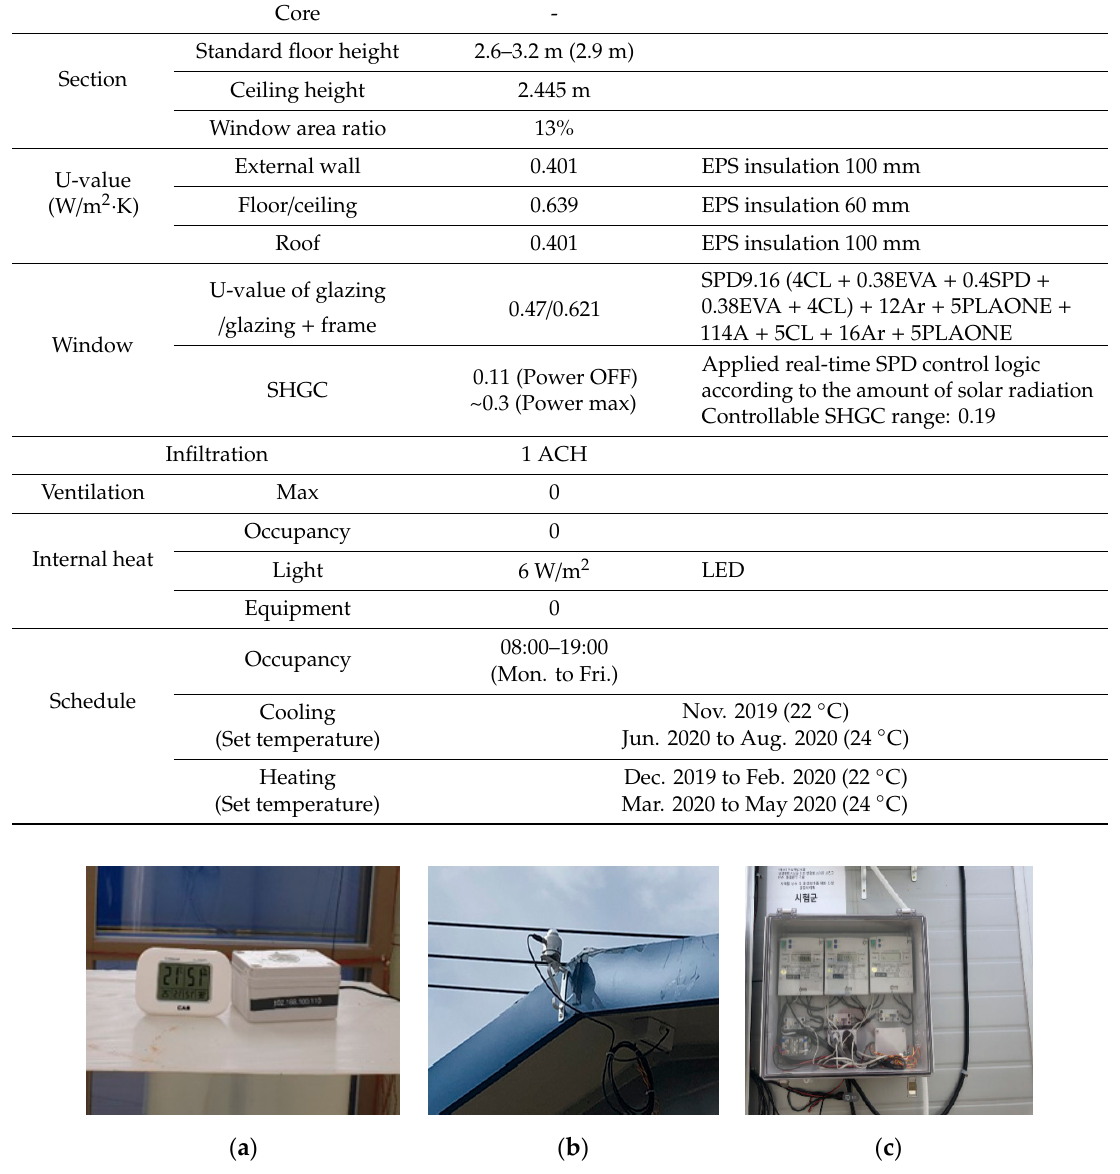
Figure 3. Measuring instruments: ( a ) temperature/humidity combined sensor; ( b ) hemispherical solar radiation sensor; ( c ) power meter.